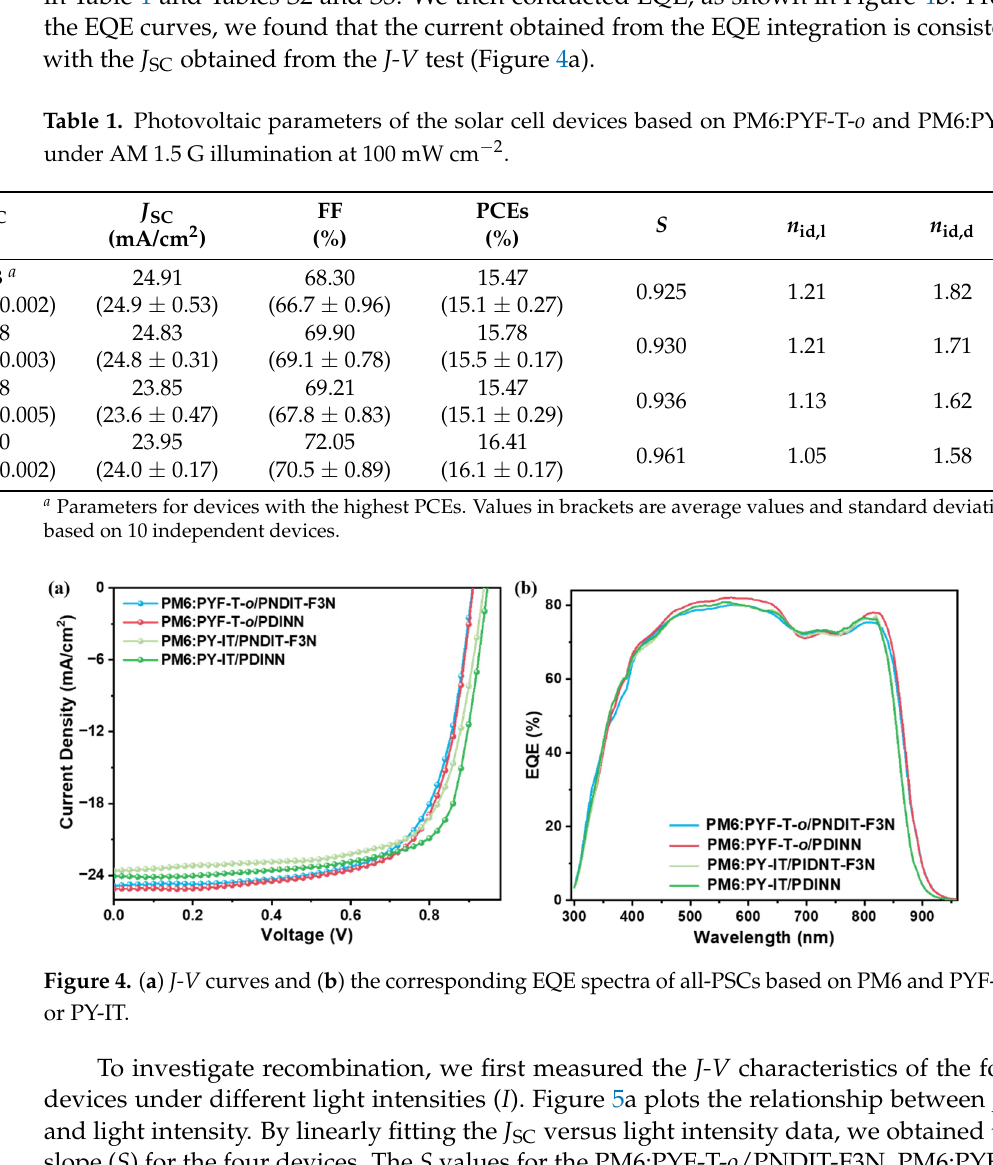
Table 1. Photovoltaic parameters of the solar cell devices based on PM6:PYF-T- o and PM6:PY-IT under AM 1.5 G illumination at 100 mW cm − 2 .